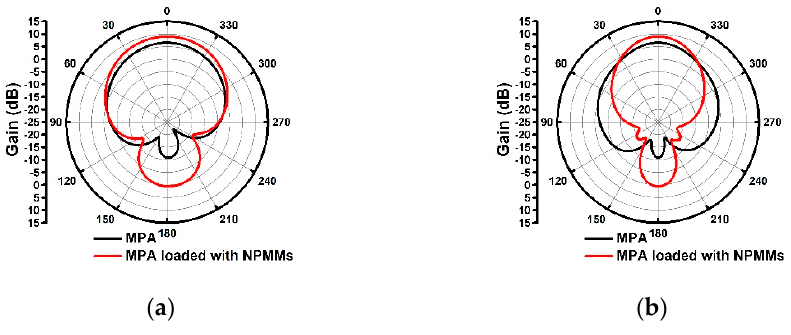
Figure 4. Simulated gain comparison ( a ) E-plane; ( b ) H-plane.